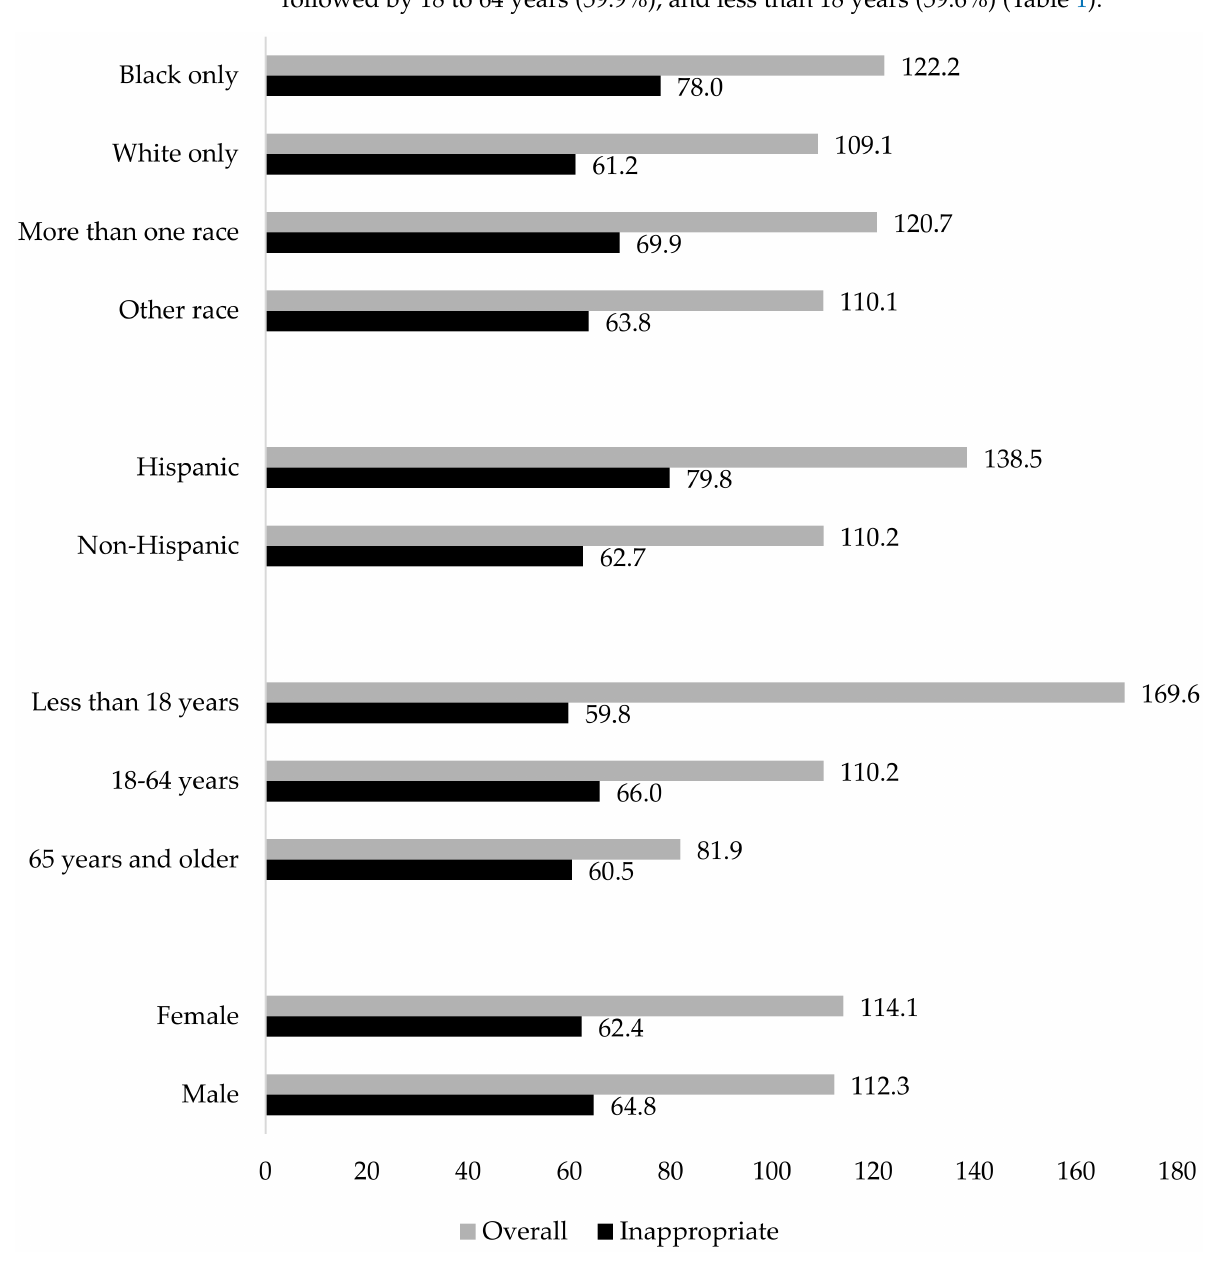
Figure 1. Rates of overall and inappropriate antibiotic prescribing per 1000 total visits by patient subgroup. p < 0.0001 for all comparisons of overall and inappropriate antibiotic prescribing rates for each